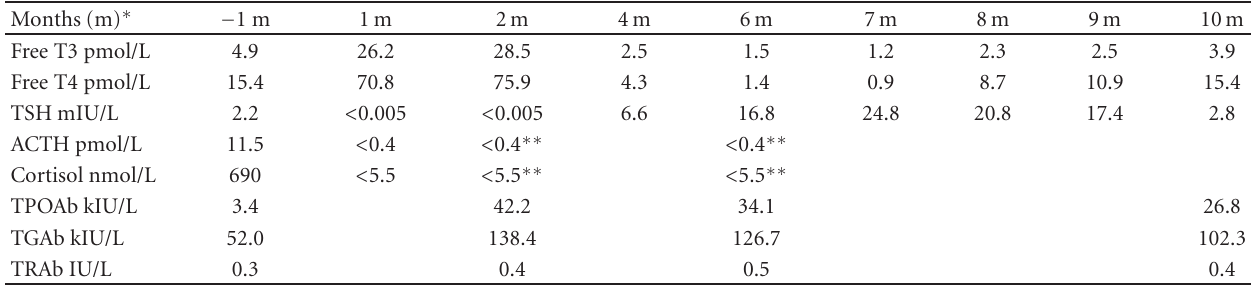
Table 1: Results of thyroid and adrenal function tests and TPOAb and TGAb at 1 month before delivery ( − 1m) (1 month ante partum)